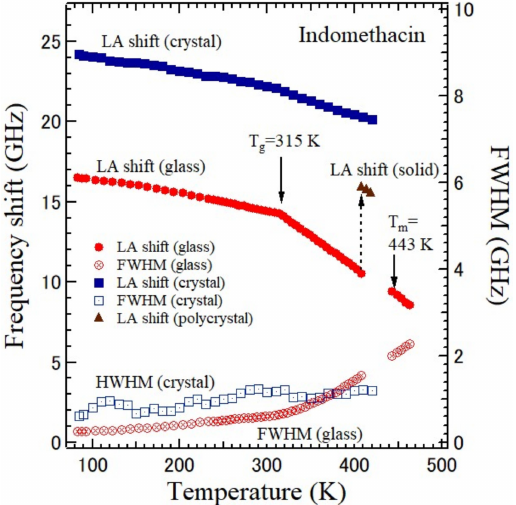
Figure 16. Temperature dependences of the LA frequency shift and FWHM of a γ -form indomethacin crystal with a triclinic structure, glass, and liquid states. The polycrystalline state created by the crystallization from a glass state at 410 K is also plotted [95].